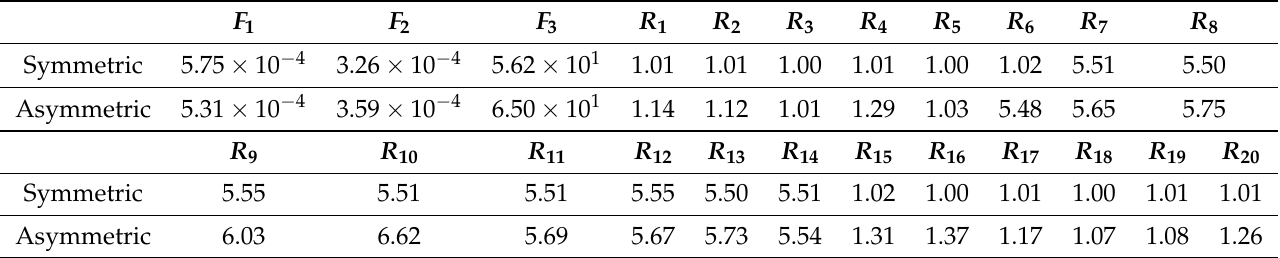
Table 6. Solutions based on the F 3 sorting in case